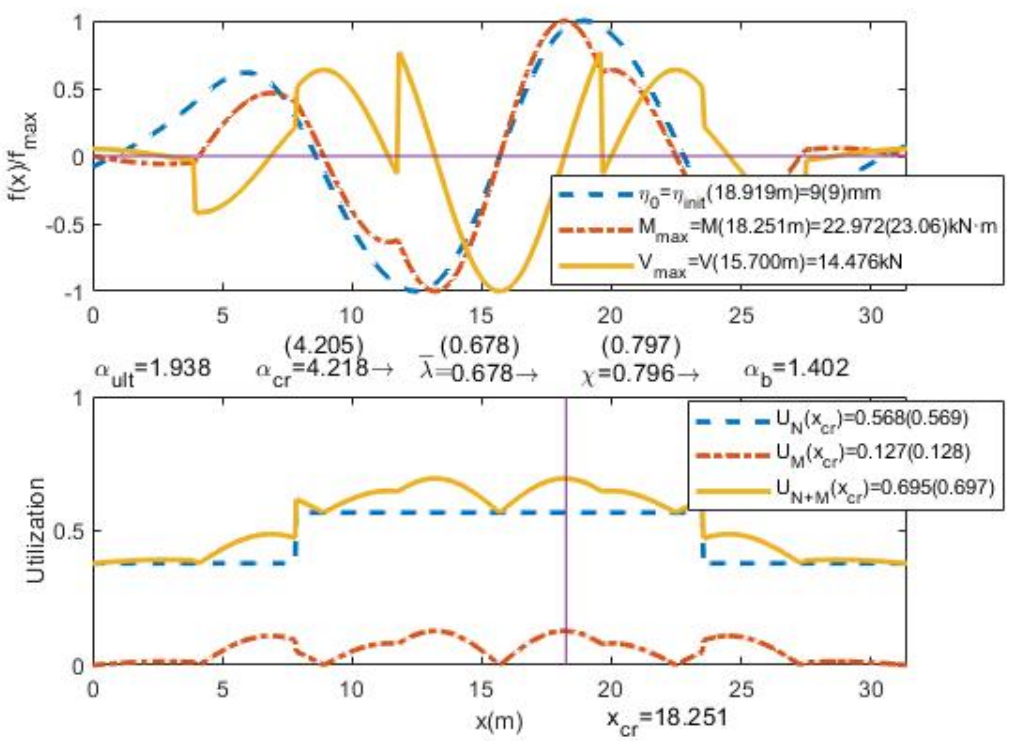
Figure 6. Example 2: UGLI imperfection η init , bending moment M , shear force V , and utilization factor U . Values in brackets are from [7].